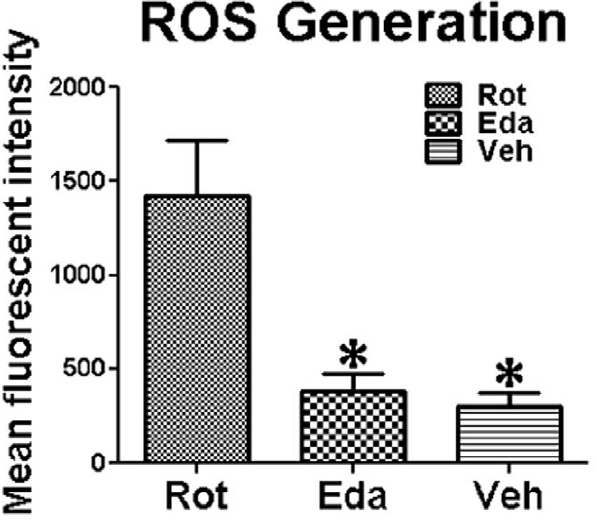
Figure 2. Effect of Edaravone on Rotenone-induced ROS generation in midbrain. Fluorescent intensity in midbrain of DCF, the product of cellular oxidation of DCFH-DA, as detected by flow cytometry for Rot-, Eda- and Veh-group (*P , 0.05 as compared to Rot- group).